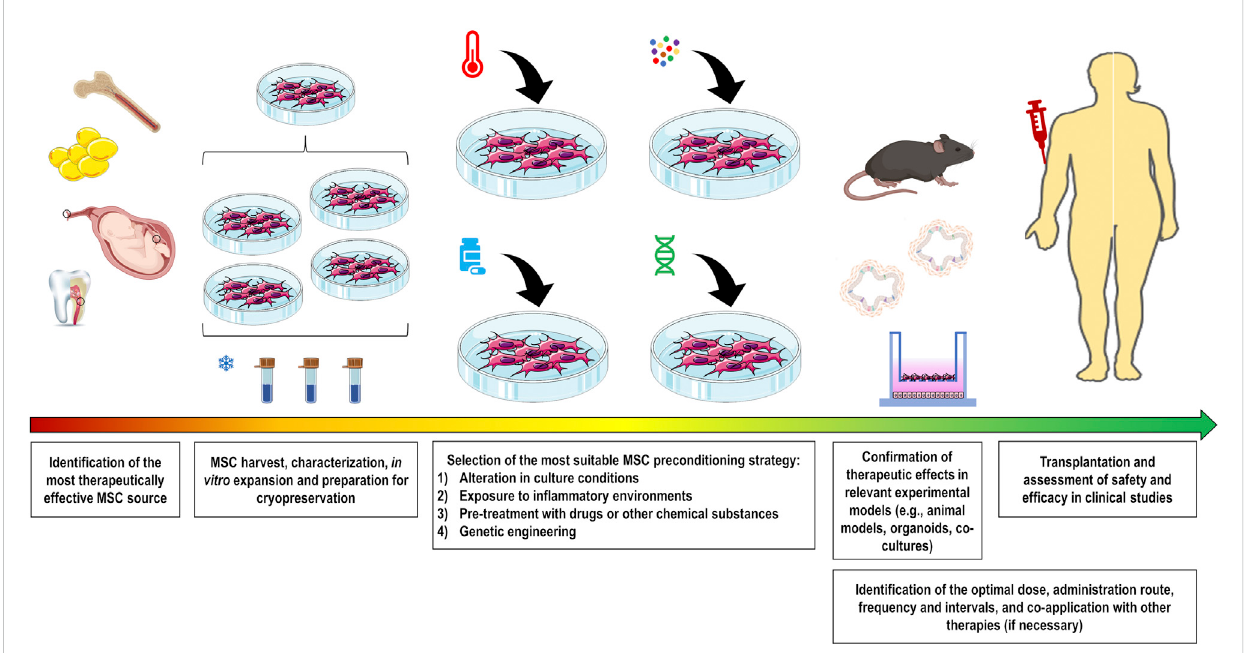
FIGURE 1 Comprehensive overview showing the production of preconditioned MSCs for pre-clinical and clinical use. Initially, the most therapeutically effective MSC source should be identi fi ed for the target disease. After harvesting, cells should be properly characterized and expanded to maximize the number of batches to be frozen. Preconditioning strategy should be selected to functionally potentiate MSC therapeutic properties. These strategies include alteration in culture conditions (O 2 or CO 2 concentration, heat shock, nutrient deprivation, and others), exposure to in fl ammatory conditions (cytokines/chemokines, growth factors, combinations thereof, or biologically relevant samples), pre-treatment with drugs or other substances, and genetic engineering to manipulate expressionlevelsof the gene of interest. The therapeutic abilities of these cells should be validated in relevant experimental models for the subsequent assessment in clinical studies. To enhance the therapeutic outcomes, there are several MSC administration conditions that need to be optimized, including the identi fi cation of the optimal dose, administration route, frequency and intervals, and co-application with other therapies if